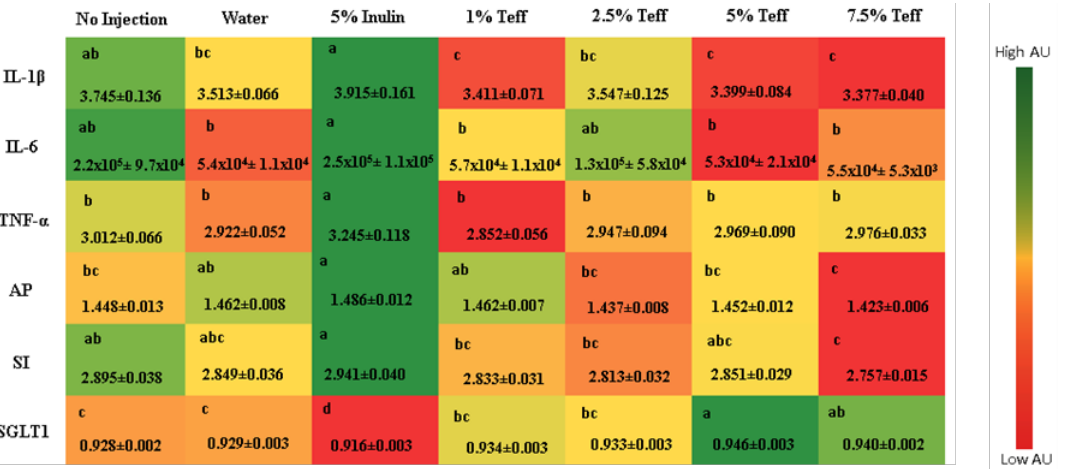
Table 8. Effect of the intra-amniotic administration of experimental teff solutions on duodenal villus and crypts measurements 1 .